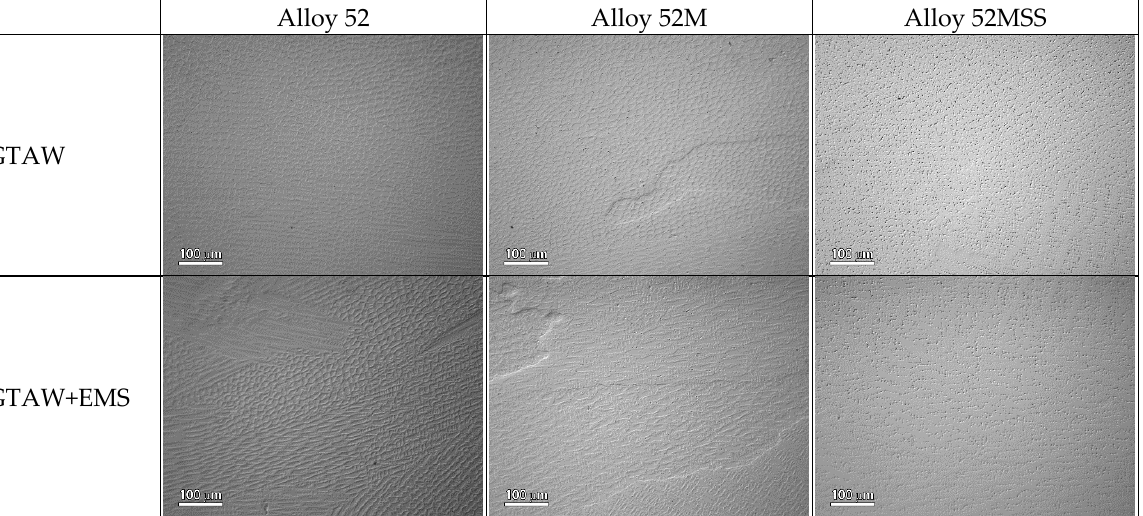
Figure 5. Micrographs of welds in the cap.